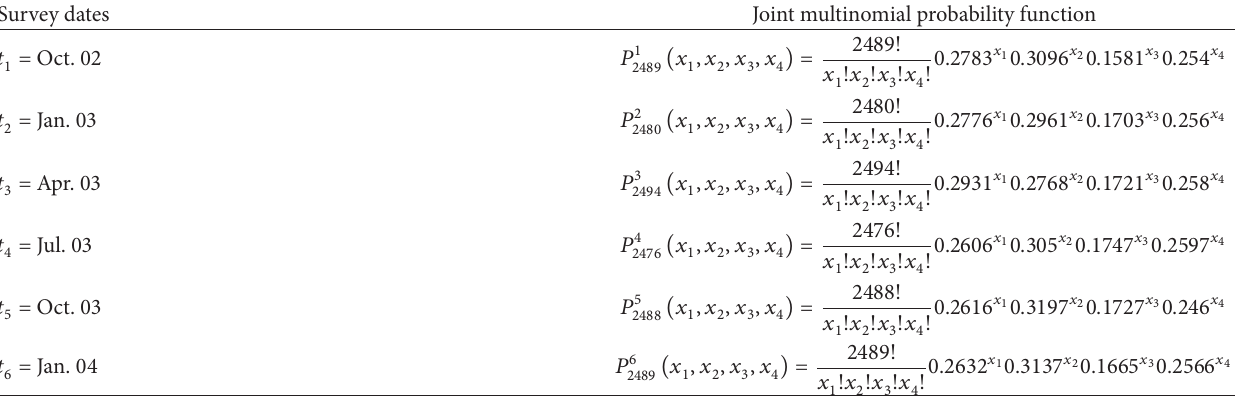
Table 3: Data distributions for probabilistic model estimation. Date and joint multinomial probability function of each survey.